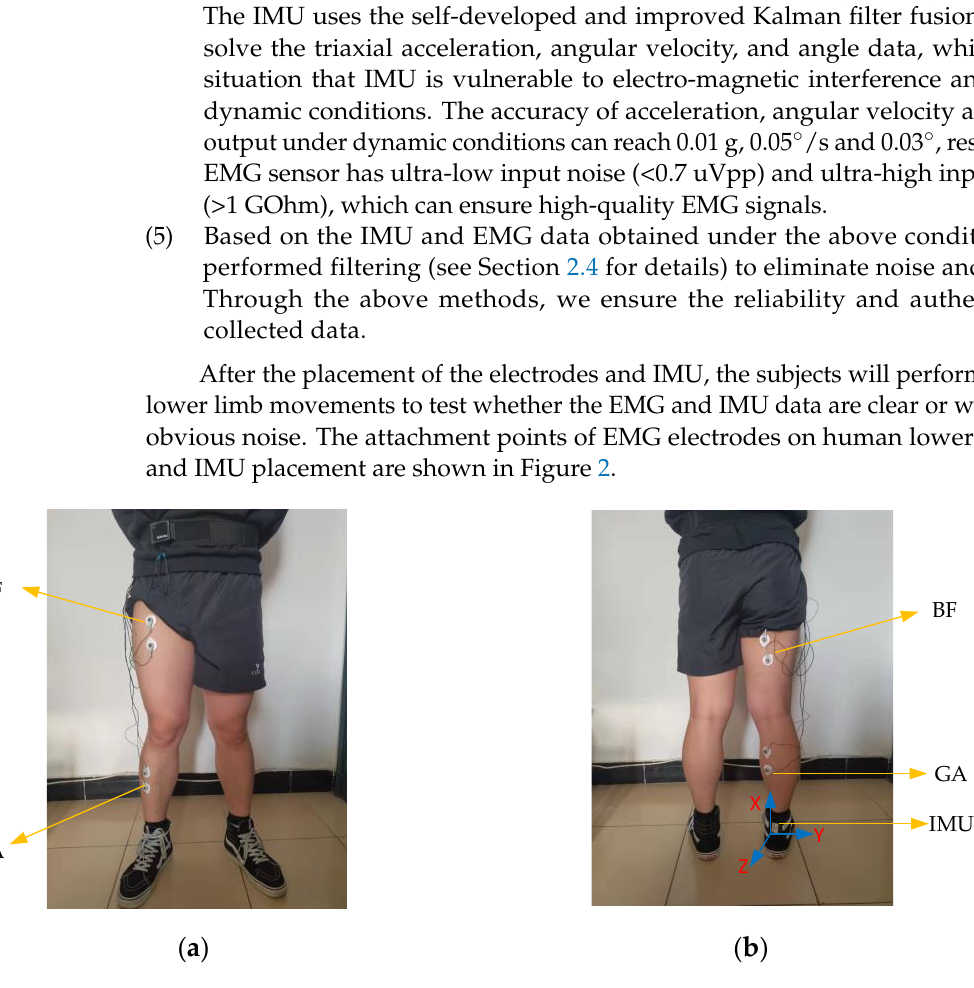
Figure 2. Electrode attachment point and IMU position. ( a ) Frontal side of human lower limbs; ( b ) back side of human lower limbs.